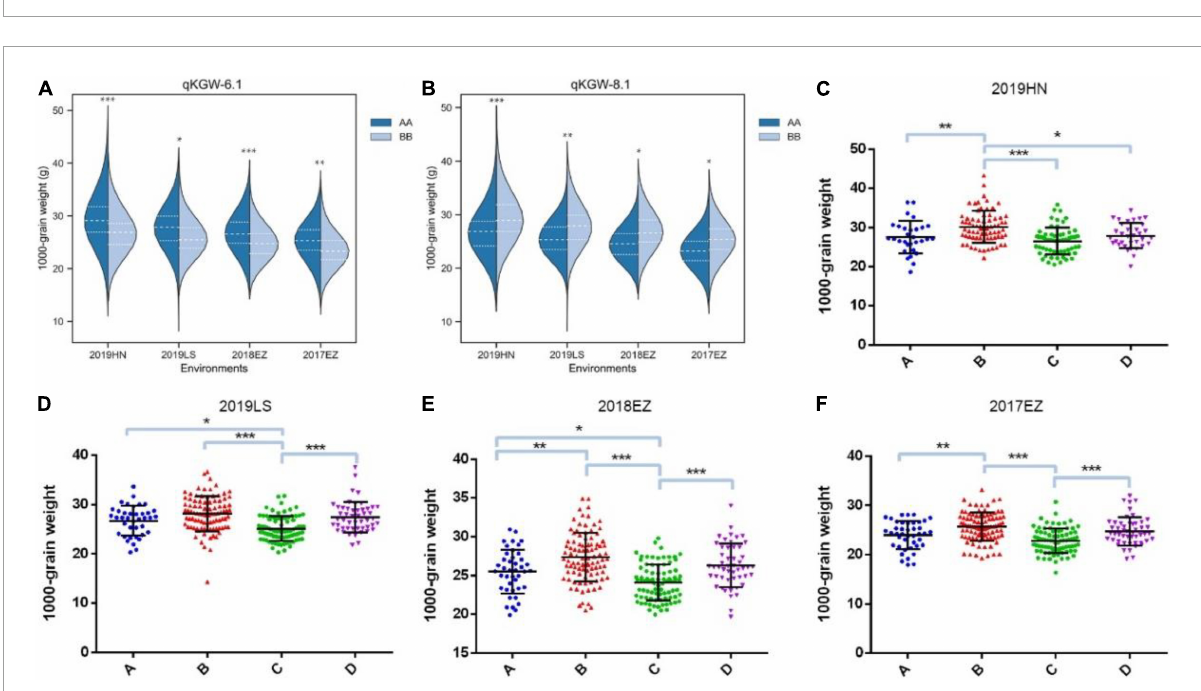
FIGURE4 1000-grain weight of different allele combinations of qKGW-6.1 and qKGW-8.1. In (A) , (C–F) : qKGW-6.1 AA + qKGW-8.1 AA, (B) : qKGW-6.1 AA + qKGW-8.1 BB; (C) : qKGW-6.1 BB + qKGW-8.1 AA; (D) : qKGW-6.1 BB + qKGW-8.1